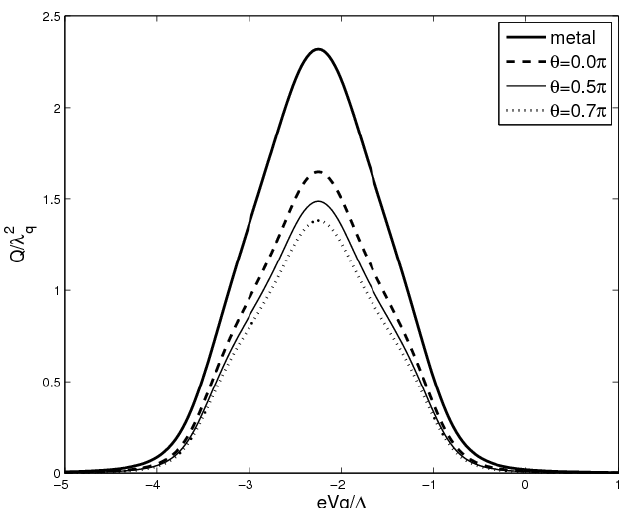
Figure 3. The heat generation Q versus the gate voltage eV g . The parameters are chosen as eV = 2.5 Δ , K B T = 0.1.